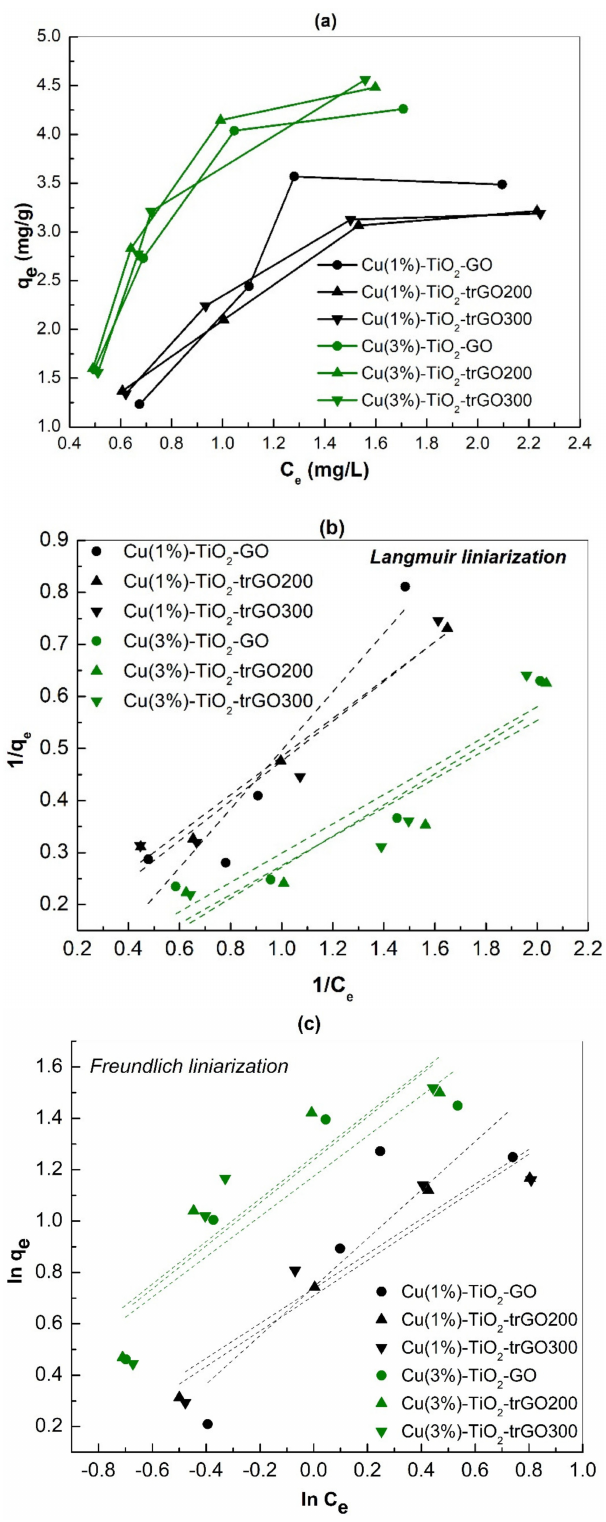
Figure 4. ( a ) Adsorption isotherms of MB dye onto Cu(1%)-TiO 2 (black) and Cu(3%)-TiO 2 (green)- graphene containing photocatalysts; ( b ) The Langmuir adsorption isotherm model fit for the ad- sorption of MB dye on Cu(1%) (black) and Cu(3%) (green)-graphene containing photocatalysts (experimental conditions: 120 min, 25 ◦ C); ( c ) The Freundlich adsorption isotherm model fit for the adsorption of MB dye on Cu(1%) (black) and Cu(3%) (green)-graphene containing photocatalysts (experimental conditions: 120 min, 25 ◦